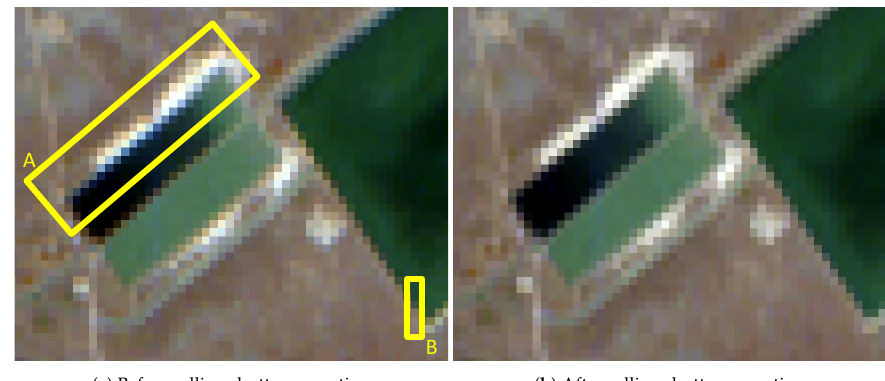
Figure 17. Intermediate DESIS L1B product before ( a ) and after ( b ) rolling shutter correction. Region A presents a bright blue line of pixels in the transition between different surfaces before applying the correction. The line disappears in ( b ) when the rolling shutter correction is applied. Region B encloses an area containing clear water and soil pixels, along with a bordering pixel that delimits both regions. The effect of the rolling shutter correction on the spectral profiles of Region B pixels is shown in Figure 18.